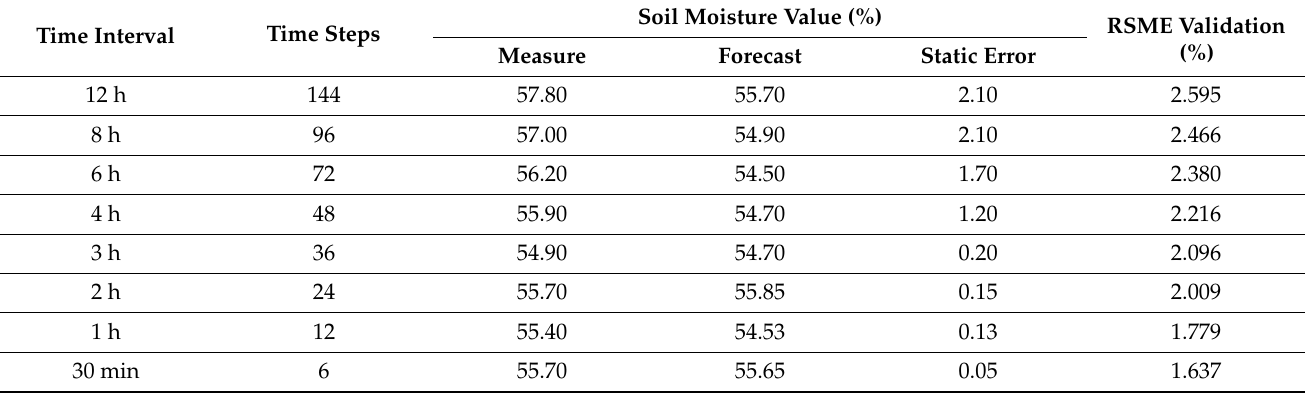
Table 7. Prediction in different time steps and time